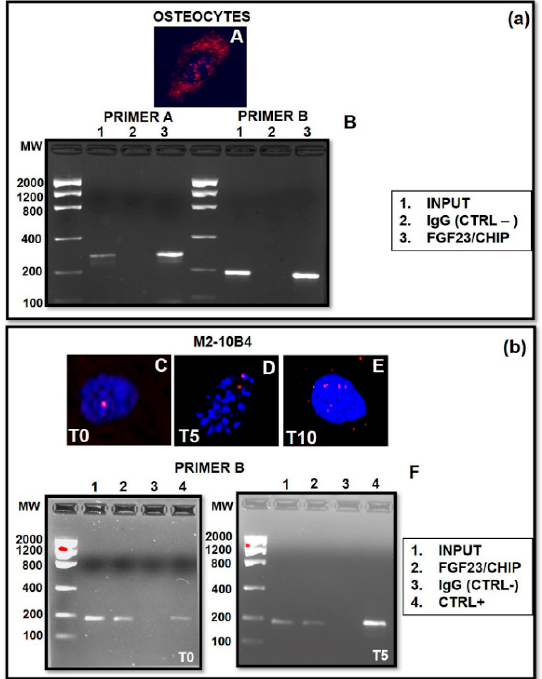
Figure 9. Nuclear localization of Fetuin-A/FGF23 interaction detected by the Duolink in situ experiment in OS T5 ( A ). Semi-quantitative PCR of Fetuin-A promoter on fragment immunoprecipitated by FGF23 of the OS Chromatin ( B ). Primer A and primer B represent 2 distinct types of primers on the same Fetuin-A promoter to validate the data. ( b ) Nuclear localization of Fetuin-A/FGF23 interaction detected by the Duolink in situ experiment in M2-10B4 at T0–T10 ( C – E ). Semi-quantitative PCR of Fetuin-A promoter on the fragment immunoprecipitated by FGF23 of the OS Chromatin ( F ). In both experiments the false positivity was excluded by the control negative, while the correctness of the PCR was confirmed by the control positive and the input.